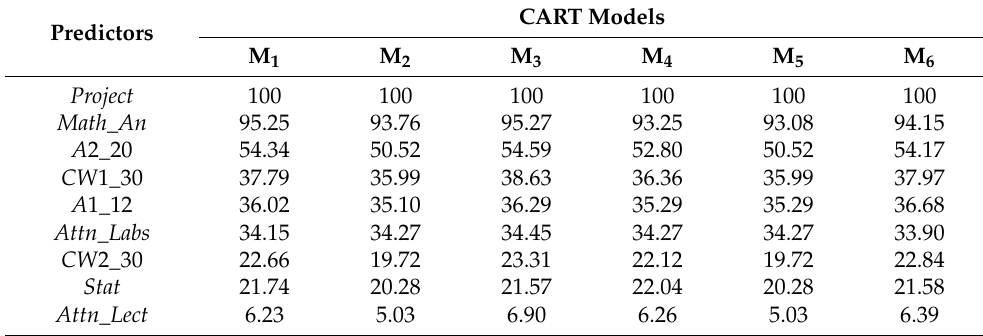
Table 4. Relative importance of the initial predictors used in the selected CART models.